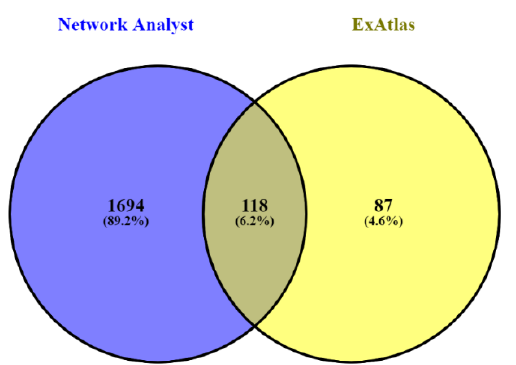
Figure 5. Venn diagram showing the genes common to teratozoospermia and azoospermia found between Network Analyst and ExAtlas. A total of 118 genes have been found to be common in Network Analyst and ExAtlas.